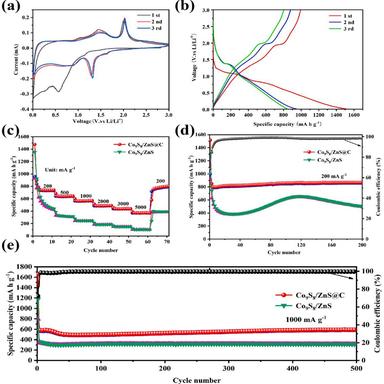
(a) CV curves of the Co9S8/ZnS@C at a sweep rate of 0.1 mV s − 1 for the first three cycles; (b) Charge-discharge curves of the Co9S8/ZnS@C in the initial three cycles; (c) Rate performance at different current densities; (d) Cycle stability at the current density of 0.2 A g− 1 ; (e) Long cycling performance at 1.0 A g− 1 .